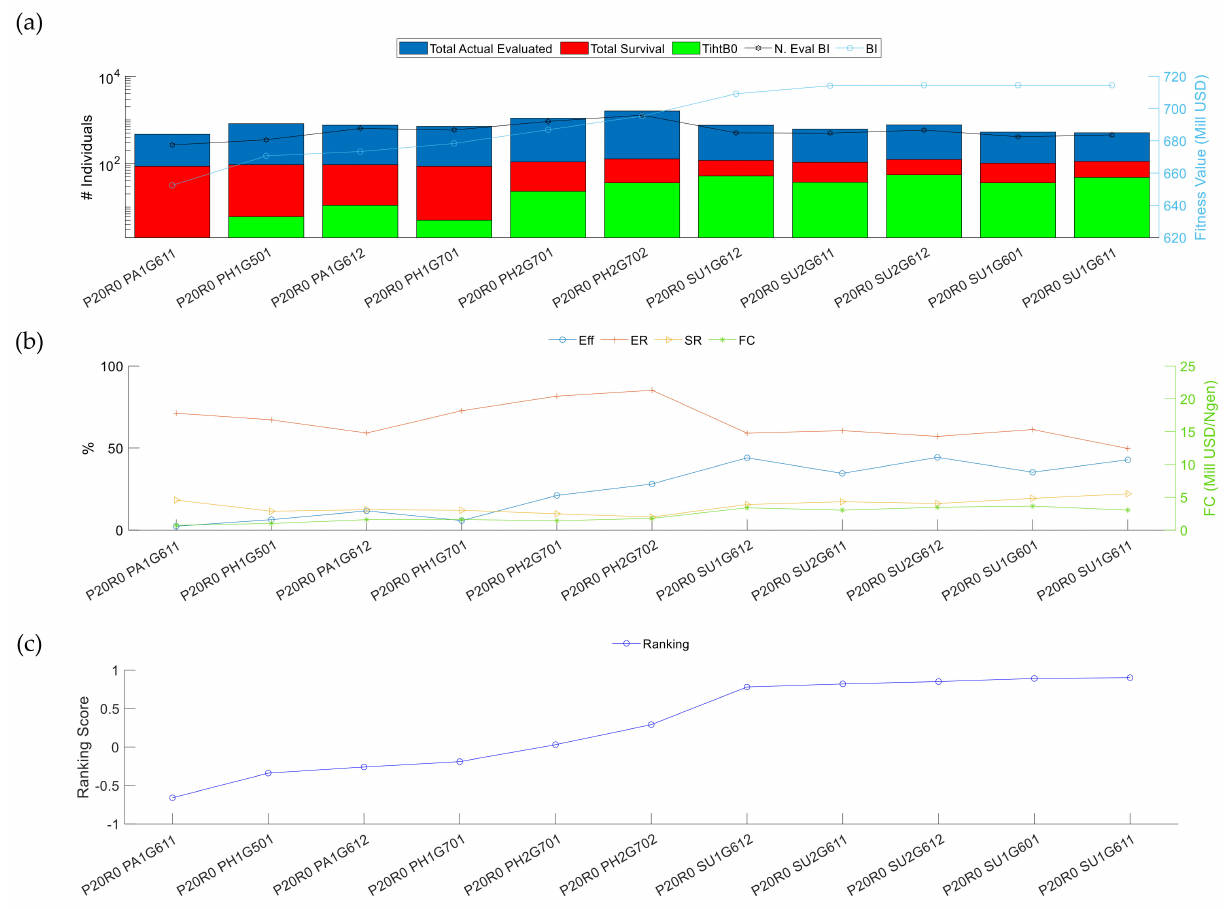
Figure 22. Summary of the performance indicators for analysis I, Section 3. ( a ) shows variables of KPI 3,4 and 5 in bar chart, KPI 1 and variable of KPI 7 in line chart, ( b ) shows KPI 3,4,5 and 6 in line chart, ( c ) shows the ranking score based on Table